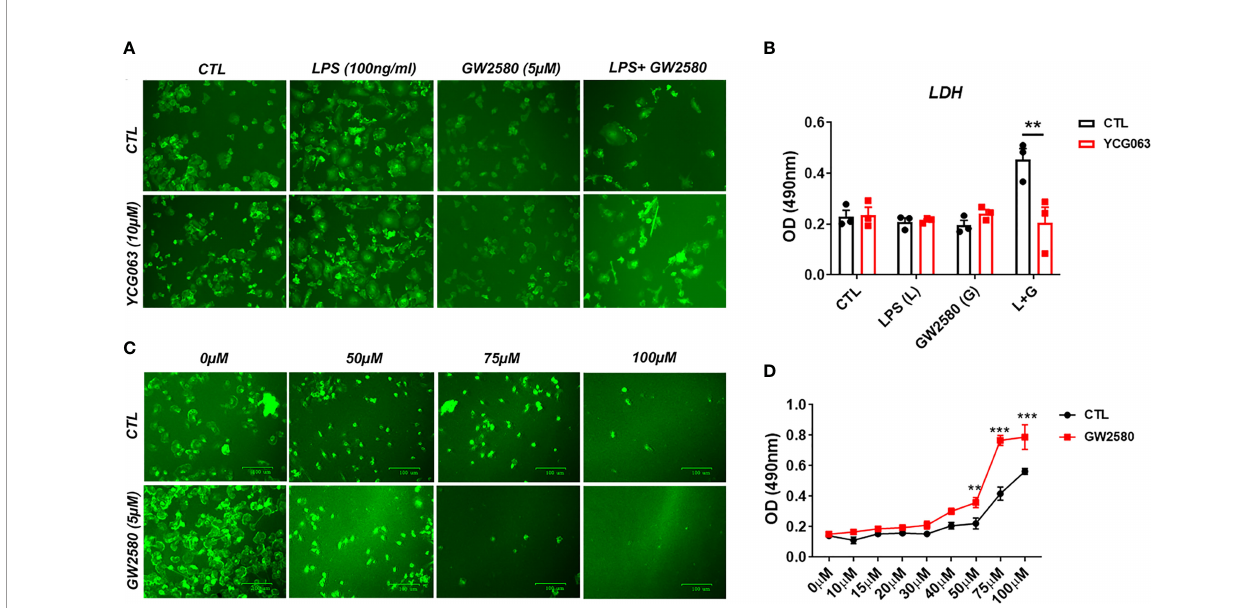
FIGURE 7 | Treatment with the ROS inhibitor YCG063 inhibits cell death in GW2580 and LPS treated cultures. (A) Microglia treatment with YCG063, a ROS inhibitor, was used to inhibit cell death. (B) LDH results for both conditions. (C) Primary microglia were stimulated with hydrogen peroxide (from 0µM- 100µM) with and without 5µM of GW2580. (D) LDH results for these conditions. Four independent cultures, represented by a total 19 neonatal pups were used for (A, B) . (C, D) Three independent experiments, in at least duplicate for each condition in (C, D) , represented by 17 neonatal pups. Data shown are expressed as means ± standard error (SE). Statistical signi fi cance is represented by p-value < 0.01 (**) and p-value < 0.001